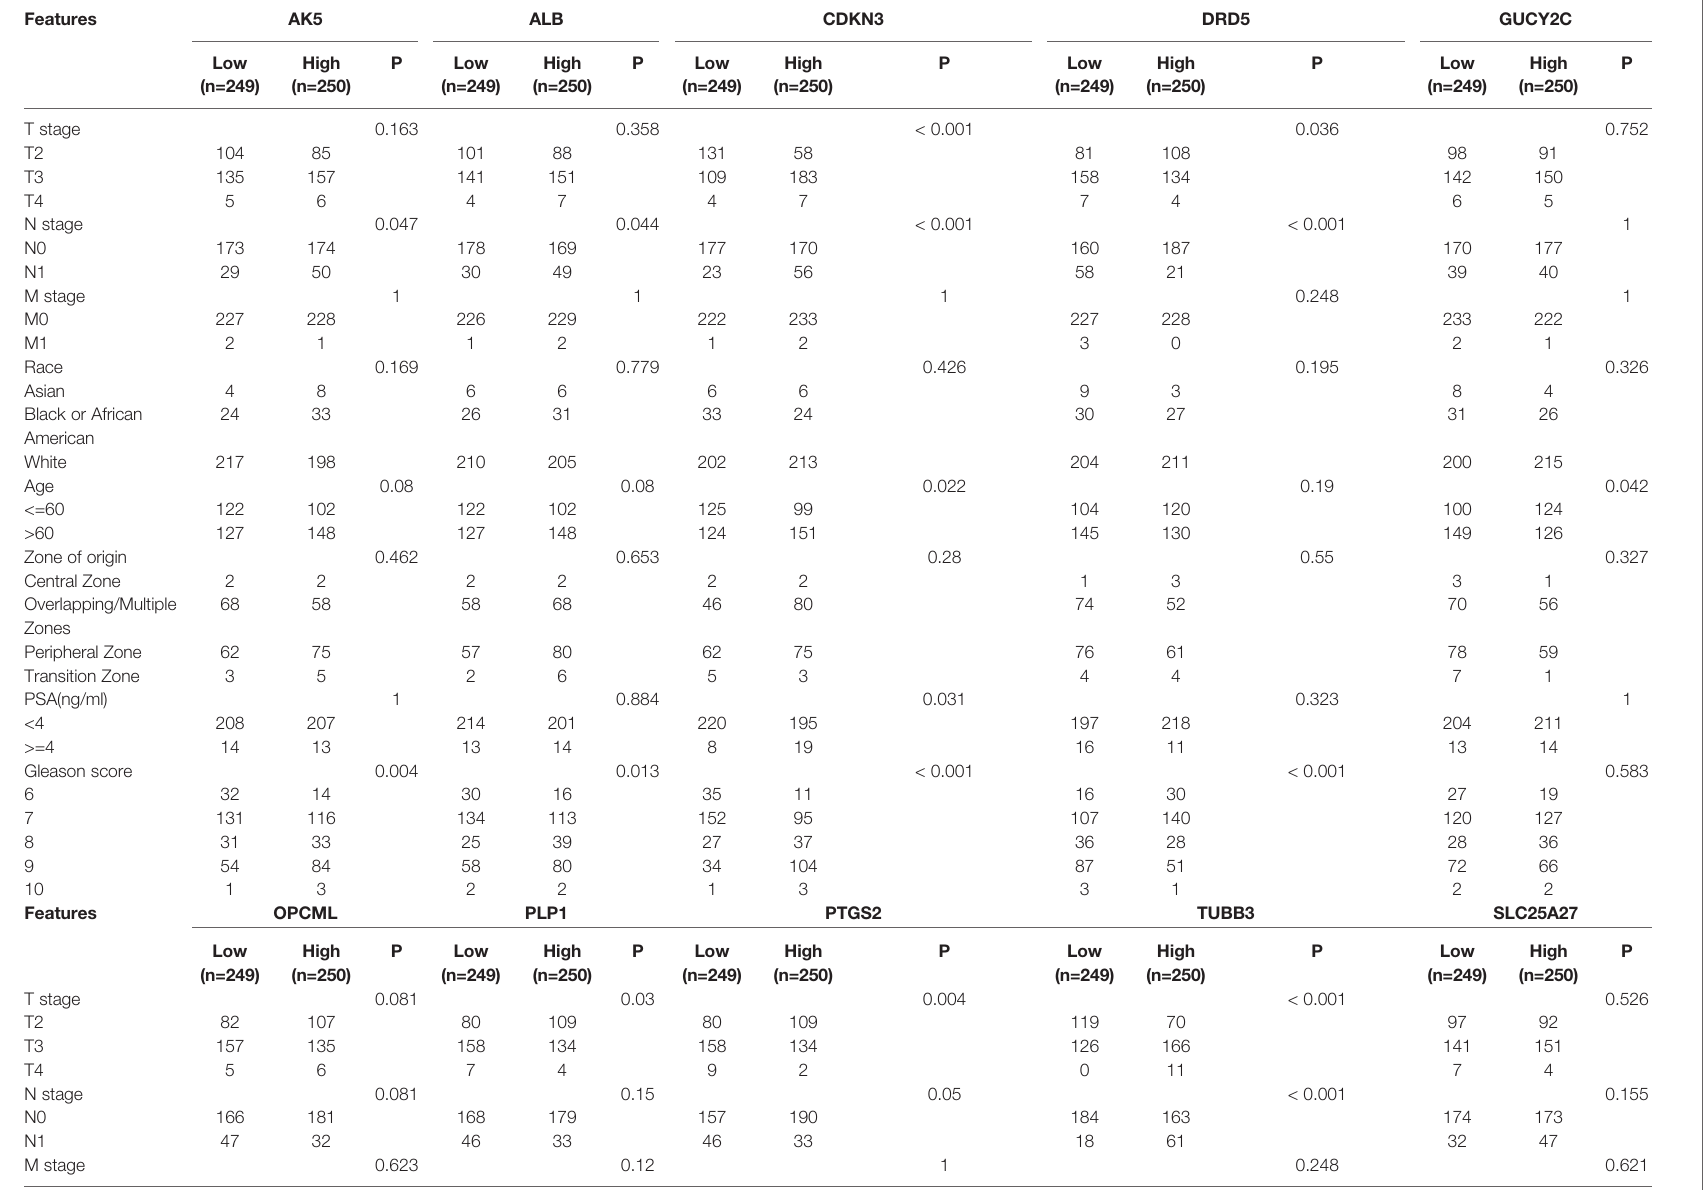
TABLE 2 | The basic clinicopathologic characteristics of enrolled genes in PCA patients based on TCGA database.